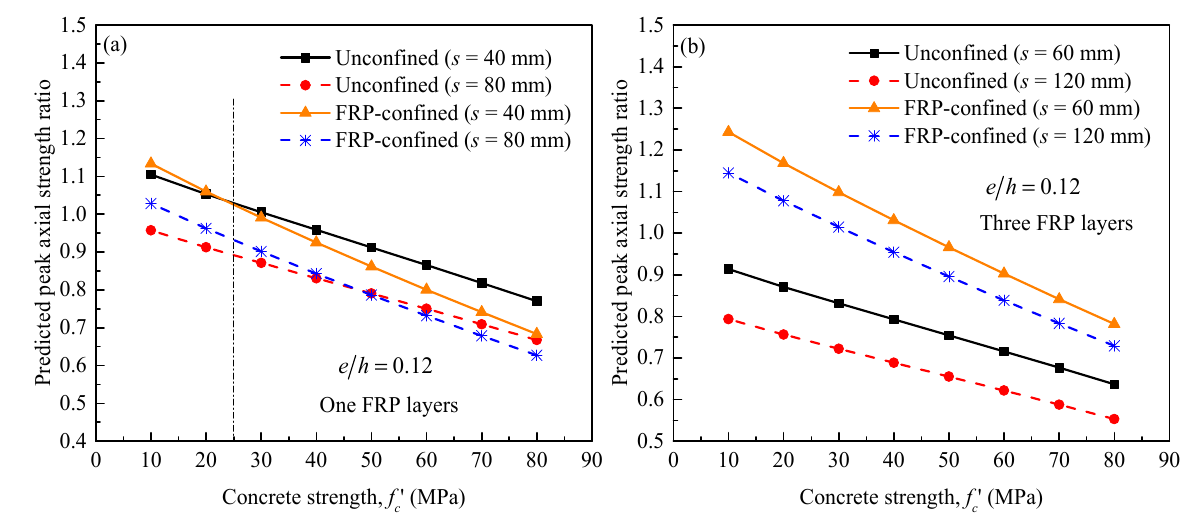
Figure 16. Predicted peak load ratios for unconfined and FRP-confined RC columns versus concrete strength: considering the effect of the effects of variation in internal steel confinement. ( a ) For one FRP Layer ( b ) For three FRP Layers. Table 7. Comparison between reduction in tested and predicted peak strengths for selected FRP-confined RC columns tested under different eccentric loading